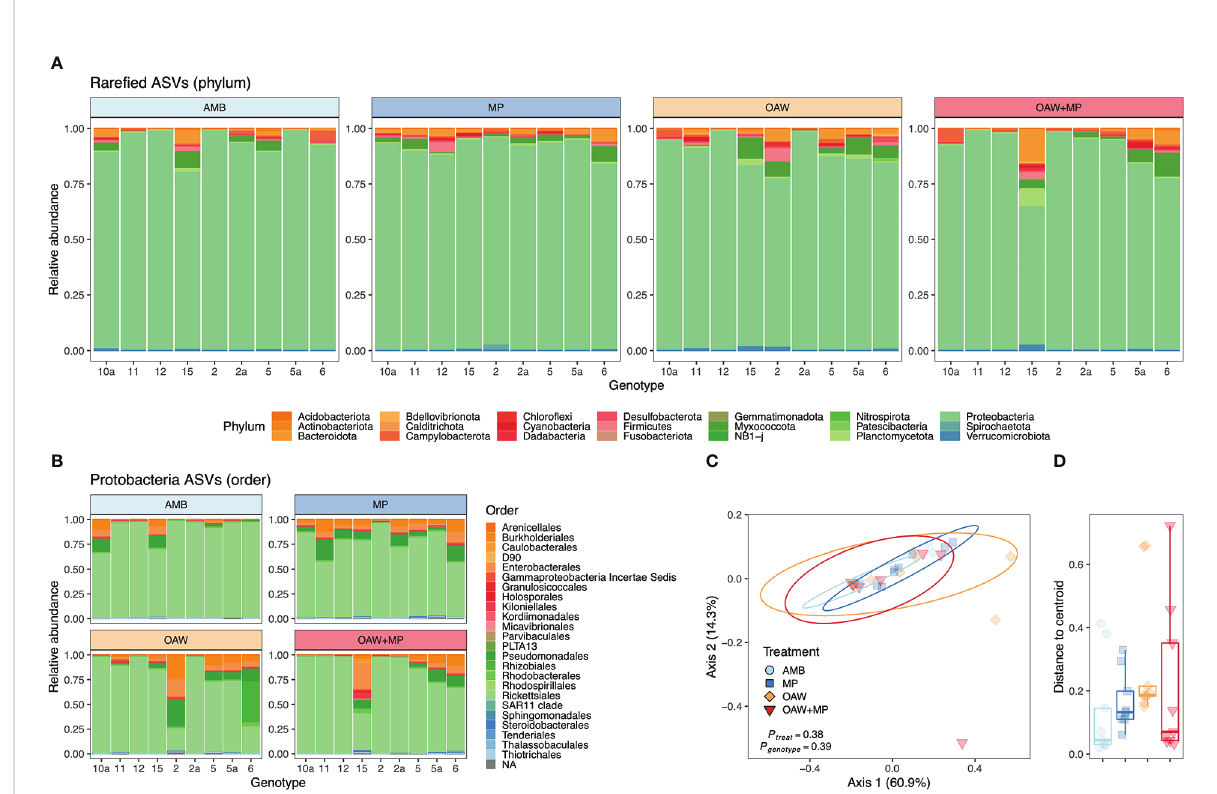
FIGURE 5 Acropora cervicornis bacterial (16S) relative abundance across fragments and experimental treatments. Diversity at the phylum level (A) depicts dominance of all samples by taxa from Proteobacteria and this (B) phylum was dominated by the order Rickettsiales in most samples. Bacterial diversity color was assigned alphabetically, not based on abundance. Beta diversity was visualized through (C) multivariate ordination plots (PCoA) of between-sample Bray – Curtis dissimilarity of rare fi ed ASVs of all taxa and (D) distance to treatment centroids. PCoA ellipses depict 95% con fi dence intervals and p-values indicate signi fi cance of treatment and genotype. Treatment is depicte-d by color in all panels: light blue = ambient conditions (AMB), dark blue = ocean acidi fi cation and warming (OAW), orange = microplastics (MP), and red = OAW and MP